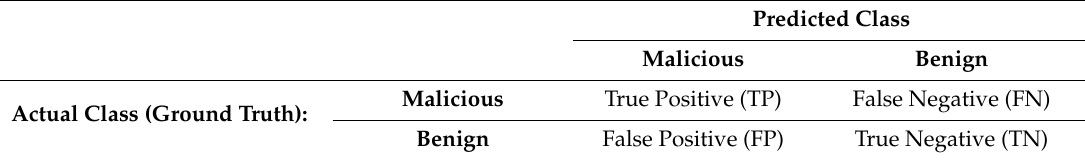
Table 2. Results of random assignment experiment with the test